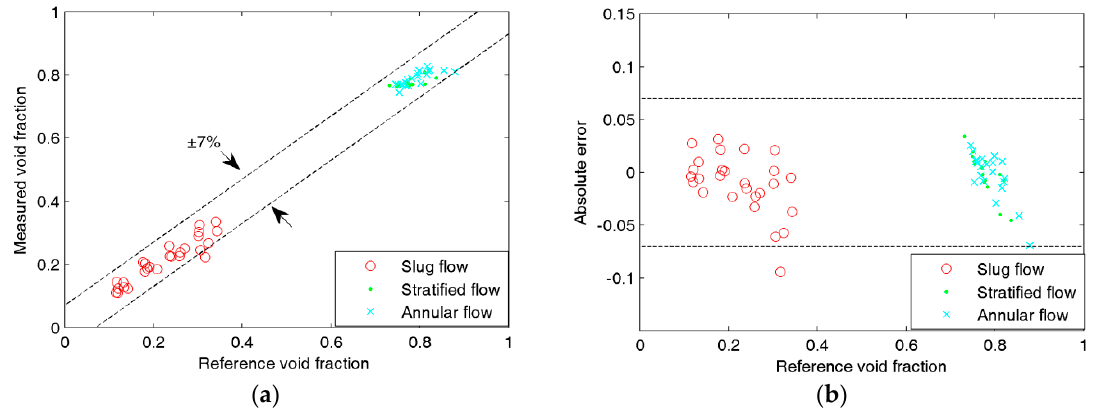
Figure 11. Experimental results of the void fraction measurement in the 1.08-mm i.d. chanel: ( a ) Comparison between measured and reference void fractions; ( b ) Absolute errors of the void fraction measurement.